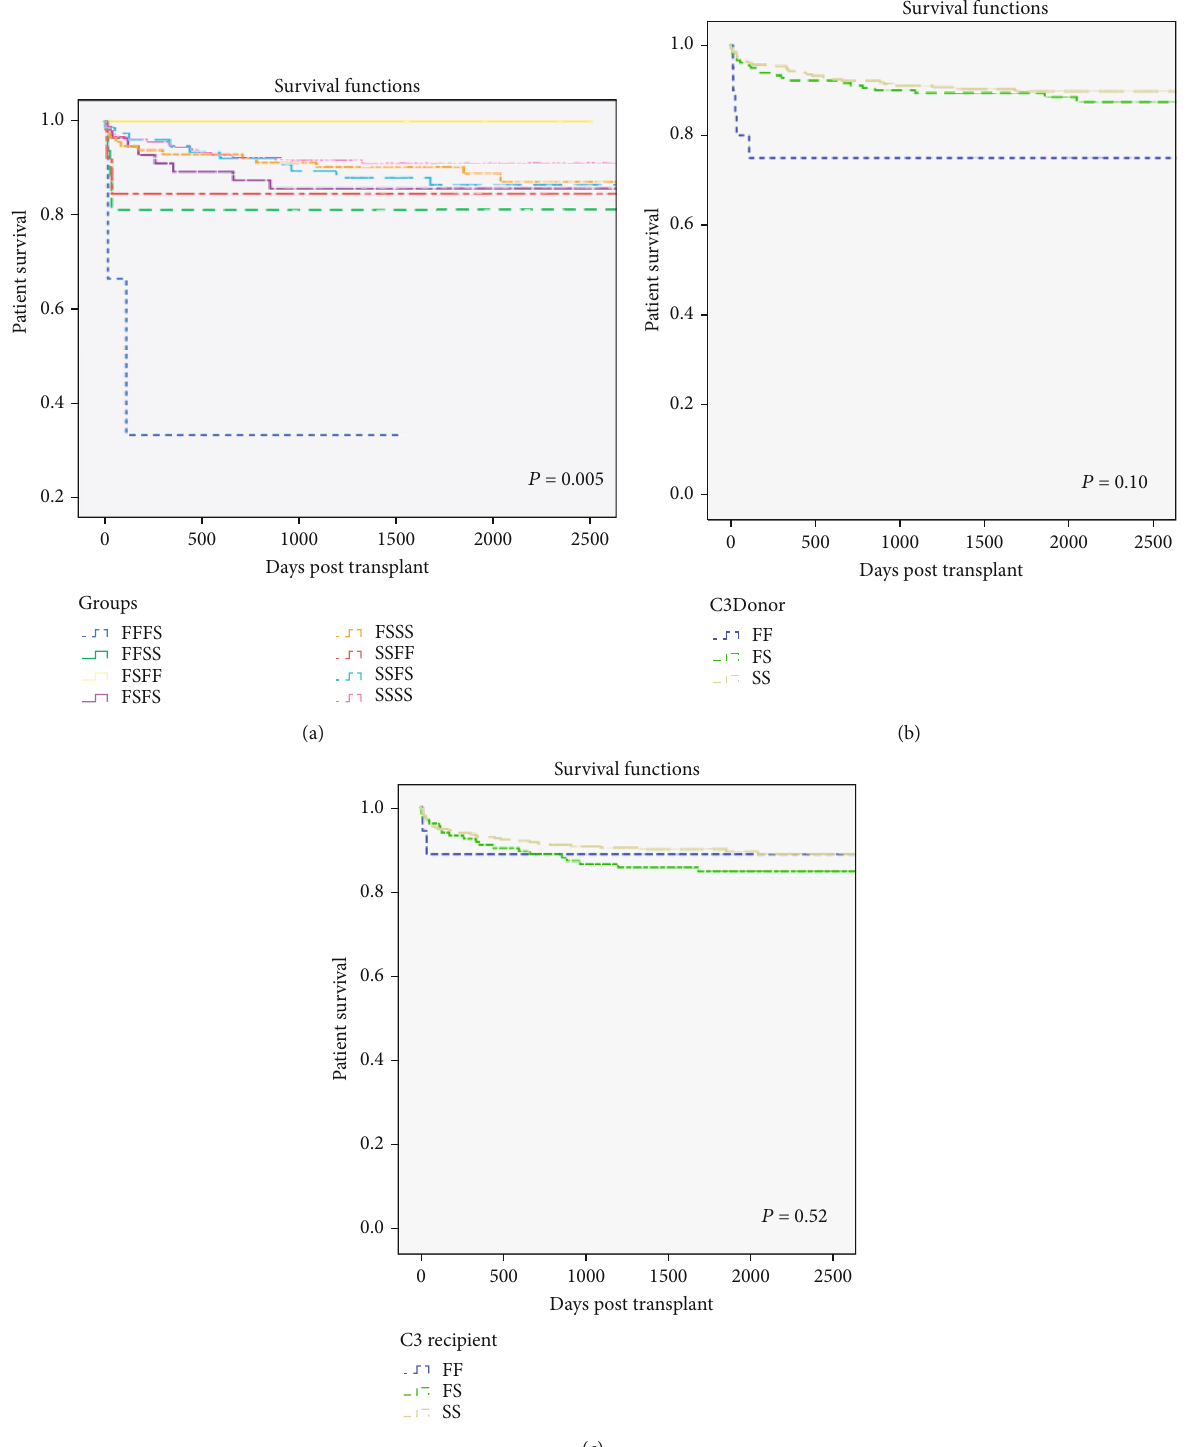
Figure 2: Patient survival by donor/recipient complement C3 genotype. Patient survival numbers at risk and log-rank ( P values are shown) up to 2500 days. Paired groups (a) and donor and recipient individual groups (b, c) according to C3 genotype and presence of C3F allele (b, c). P = 0 : 005 for genotype groups. (a) Donor ’ s presence or absence of C3F allele, P = 0 : 10 ; (c) recipient ’ s presence or absence of C3F allele, P = 0 : 52